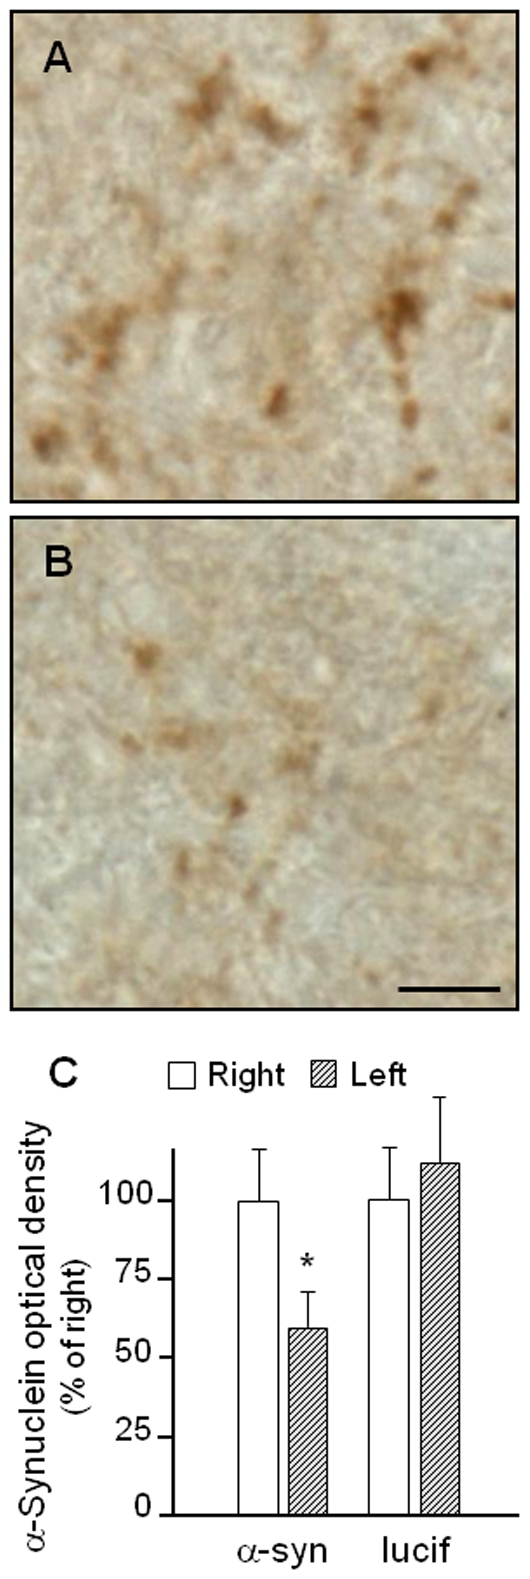
Effect of α-synuclein siRNA on α-synuclein protein in the monkey substantia nigra.α-Synuclein or luciferase siRNA was unilaterally infused into the left substantia nigra. Midbrain sections were immunostained with an antibody against α-synuclein. Representative images from an animal receiving α-synuclein siRNA show more robust α-synuclein immunoreactivity within the neuropil of the right (untreated, A) vs. left (siRNA-infused, B) substantia nigra. Scale bar = 5 µm. (C) Optical density measurements of nigral α-synuclein immunoreactivity. Data are expressed as percent of the control value in the right (untreated) substantia nigra and represent mean ± SEM. A significant decrease is caused by α-synuclein but not luciferase siRNA in the left (siRNA-infused) hemisphere. *p<0.03.